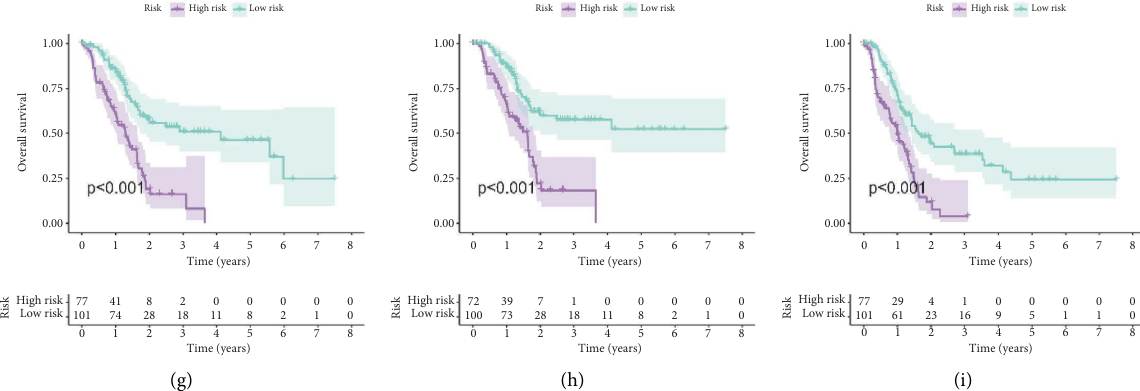
Figure 3: Kaplan–Meier curves of the risk score based on OS, DSS, and PFS in the three sets. (a) OS, (b) DSS, and (c) PFS in the training set. (d) OS, (e) DSS, and (f) PFS in the validation set. (g) OS, (h) DSS, and (i) PFS in the entire